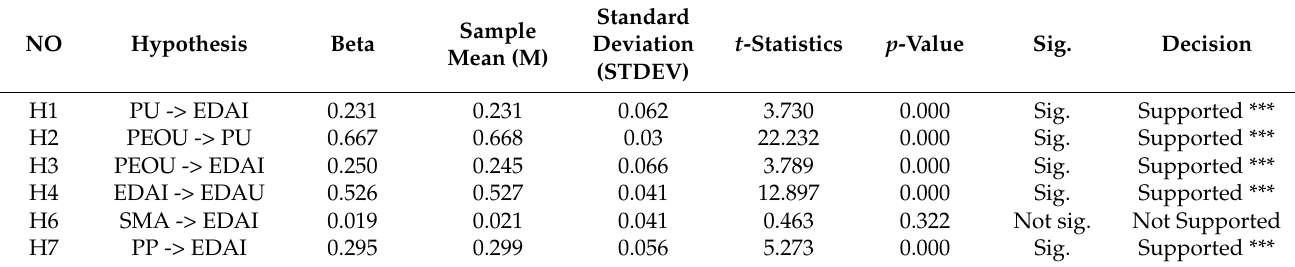
Table 4. The assessment of the structural model.